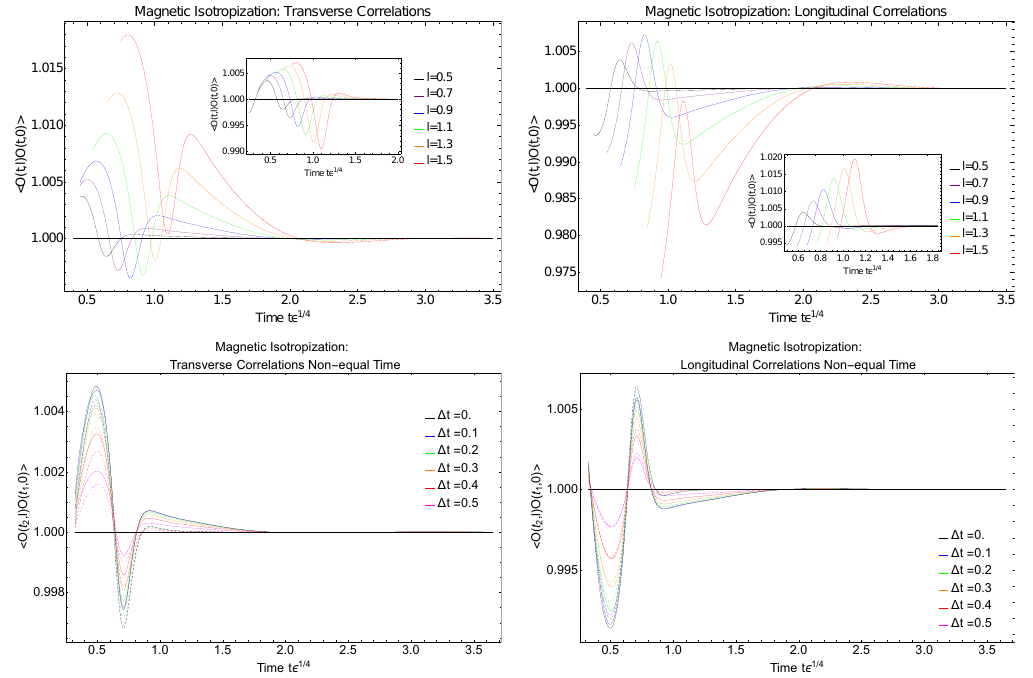
Figure 13 . 2-point correlation functions of an (uncharged) scalar operator in a neutral thermalizing (cid:13)uid (dual to evolution towards a magnetic black brane geometry), (cid:26) = 0, B = 1, case (c) in (cid:12)gure 1. Top Left: various length separations in the transverse direction at (cid:1) t = 0. Top right: various length separations in the longitudinal direction at (cid:1) t = 0. Bottom left: various time separations (cid:1) t , (cid:12)xed transverse length separation l = 0 : 65. Bottom Right: various time separations (cid:1) t , (cid:12)xed longitudinal length separation (cid:1) l = 0 : 65. The purely anisotropic case (a) is shown for comparison in the top graphs as an inset, and in the bottom graphs as dashed